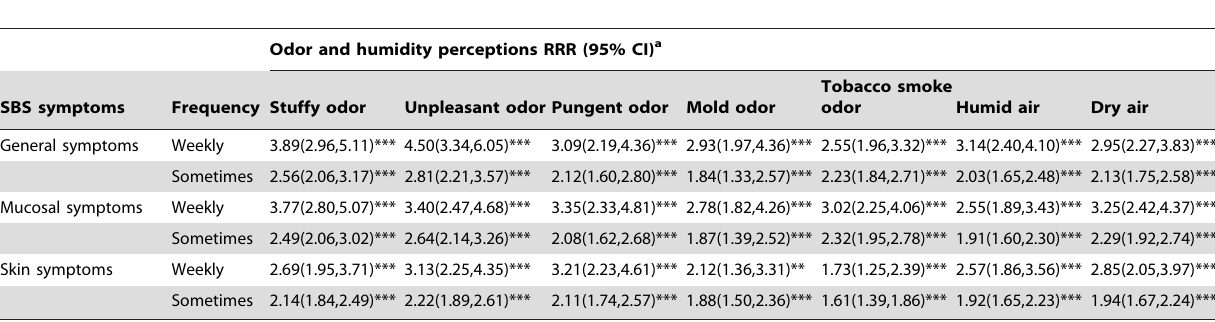
Table 5. Associations between odor and humidity perceptions and SBS symptoms analyzed by multi-nominal regression analyses (n=4530).